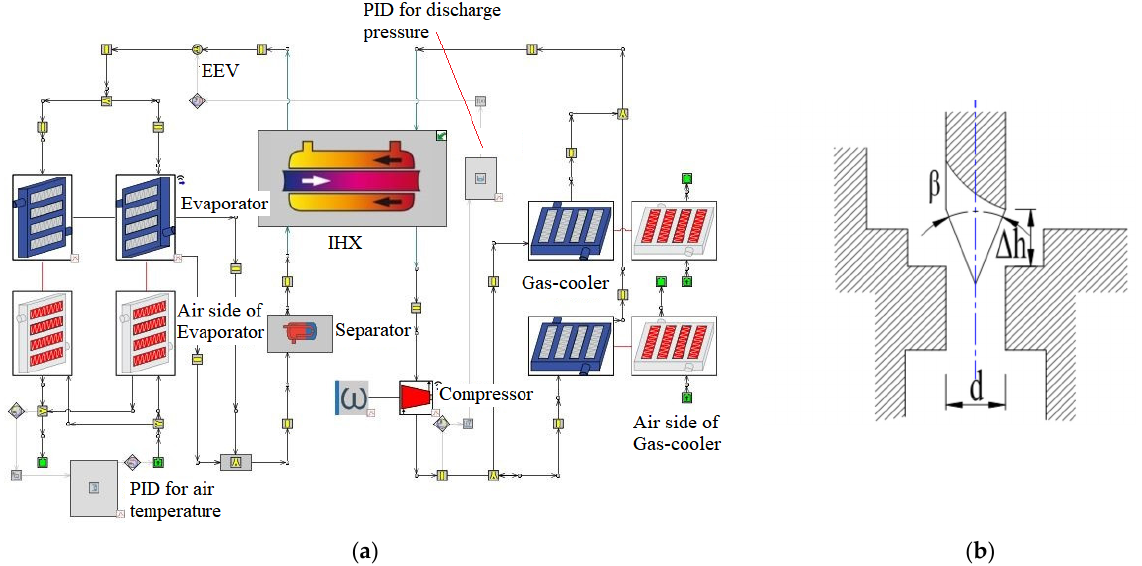
Figure 2. ( a ) The GT-Suite simulation model of the transcritical CO 2 -based bus air conditioning/heat pump system. ( b ) The sketch of the EEV structure. pump system. ( b ) The sketch of the EEV